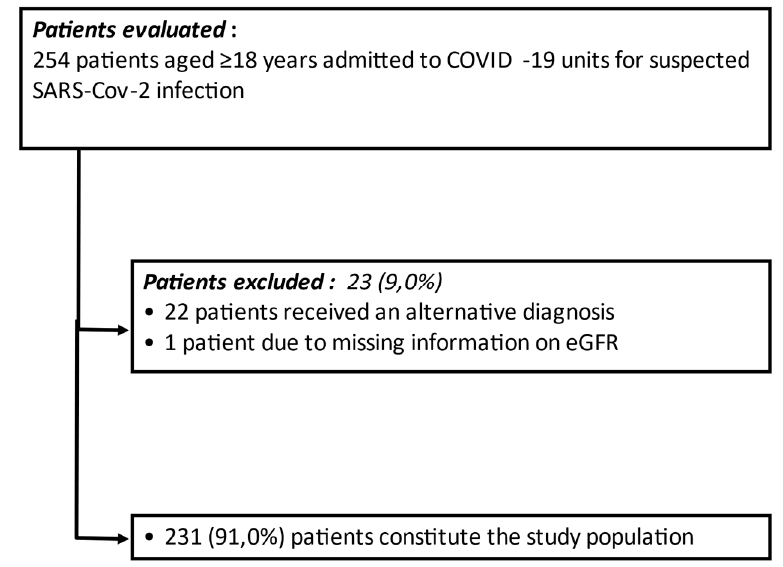
Figure 1. The number of patients evaluated for study inclusion, the number of patients excluded from the study with relative reason, and the number of patients included in the study.